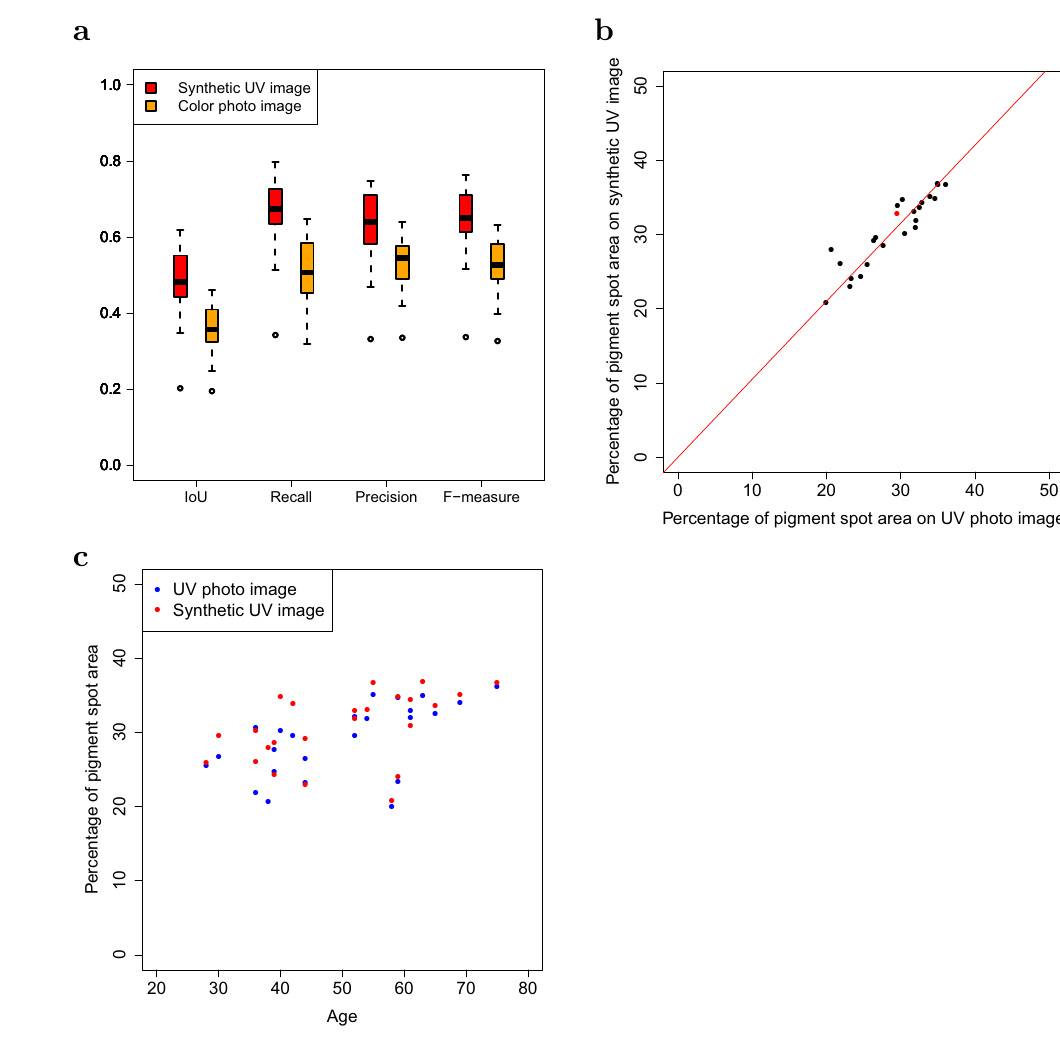
Figure 5. ( a ) Boxplots of IoU, recall, precision, and F-measure of Spot Net for synthetic UV images and color photo images for 24 test samples. ( b ) A plot comparing the percentages of pigment spots in cheek regions between UV photo images and synthetic UV images by UV-photo Net for the test samples. Dots indicate pairs of the percentages, and the red line is a linear regression line without intercept for the pairs of the percentages. The regression coefficient is 1.05. The red dot indicates the pair of the percentages for the subject in Fig. 4. ( c ) A plot showing the relationship between the age and percentage of pigment spot areas for UV photo images and synthetic UV images by UV-photo Net for the test samples. The x-axis indicates the age of the samples, and the y-axis indicates the percentage of pigment spot areas in the cheek regions for the UV photo images and synthetic UV images of the respective